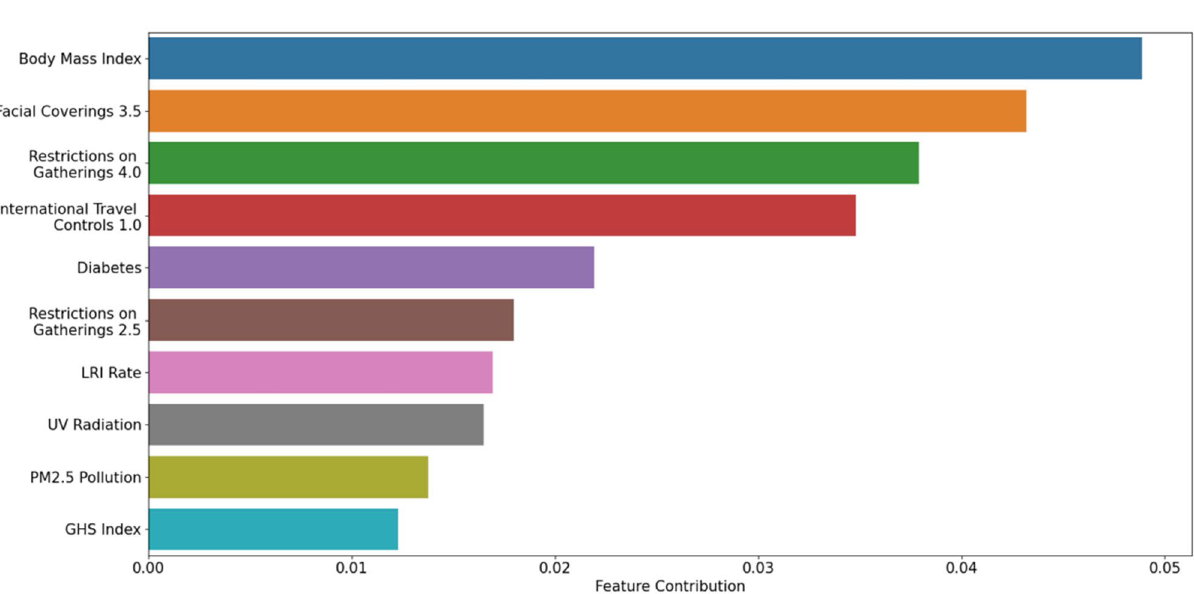
Figure 3. The effective reproduction number of COVID-19 across countries during the second wave.